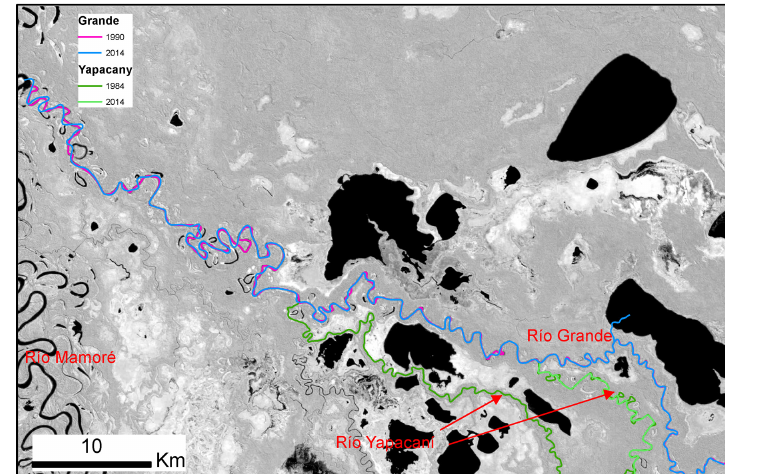
Figure 11. The last reach of the Río Grande before joining the Mamoré. The comparison between the 1990 and the 2014 Río Grande channels before and after the connection with the Río Yapacaní shows that most of the meandering of the Río Grande, when it reaches the Mamoré, is due to the sedimentary load brought by the